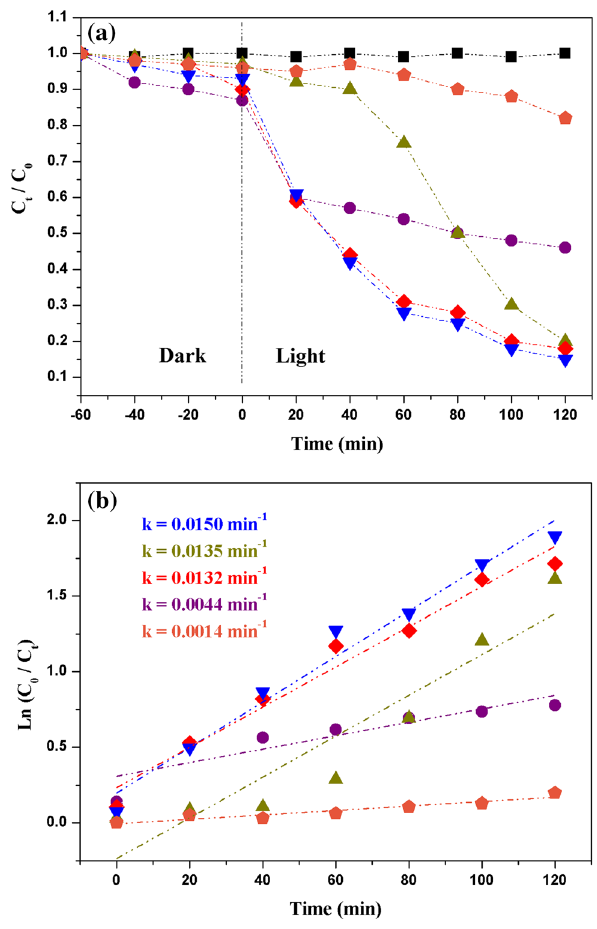
Fig. 4 a Photodegradation of 4-NP on ZrO 2 /g-C 3 N 4 nanocompos- ites under light irradiation and b the corresponding reactive constant (green color triangle: g-C 3 N 4 , violet color circle: ZrO 2 , red color diamond: 10 wt% ZrO 2 /g-C 3 N 4 , blue color down triangle: 30 wt% ZrO 2 /g-C 3 N 4 , brown color pentagon: TiO 2 , block color square: